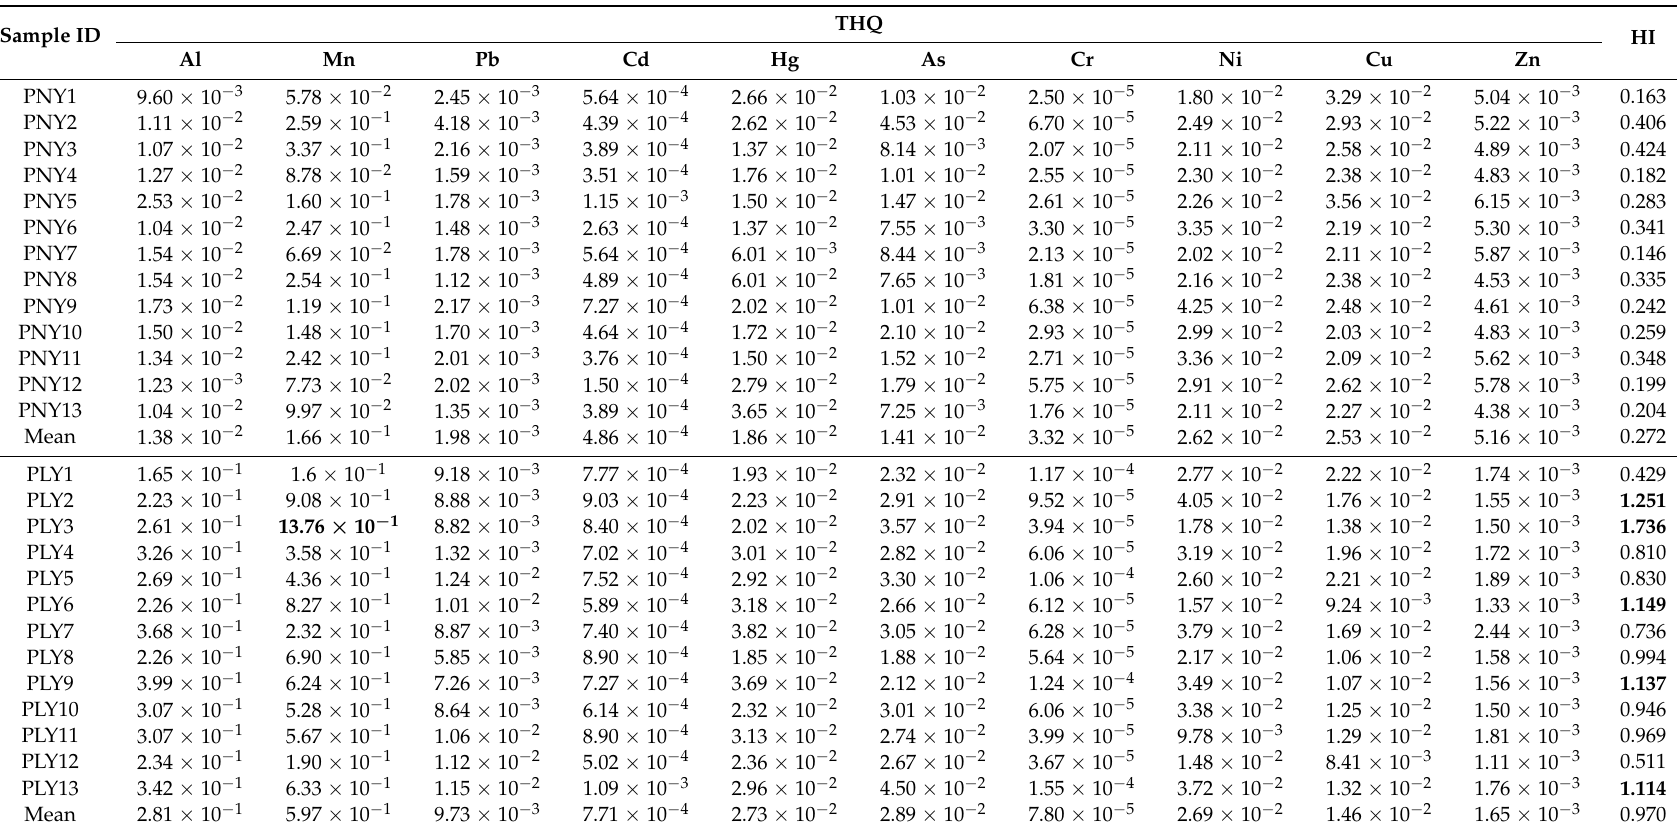
Table 6. Target hazard quotient (THQ) and hazard index (HI) values of metals for adults due to the consumption of tea leaves in Puan tea growing, Guizhou Province. Sample